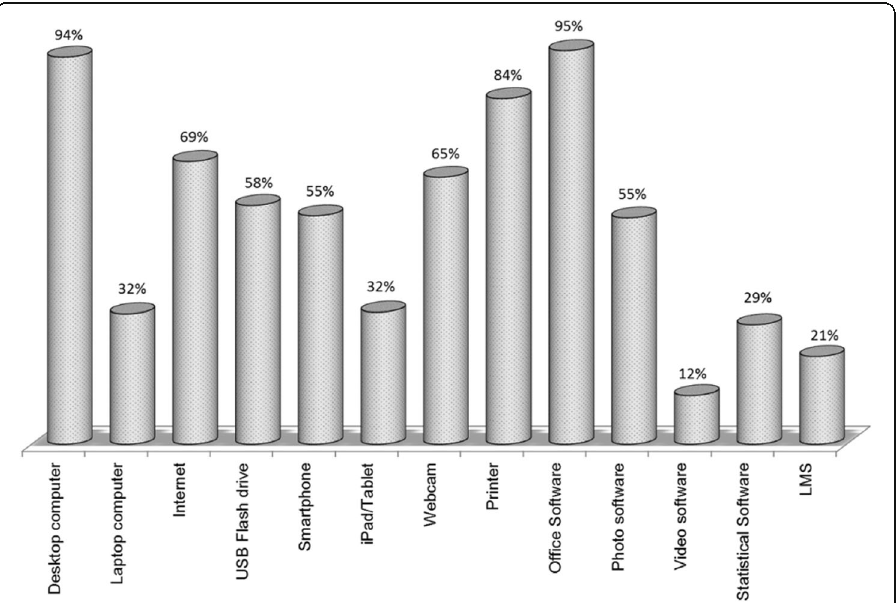
Fig. 2 Percentage of participants having physical access to various